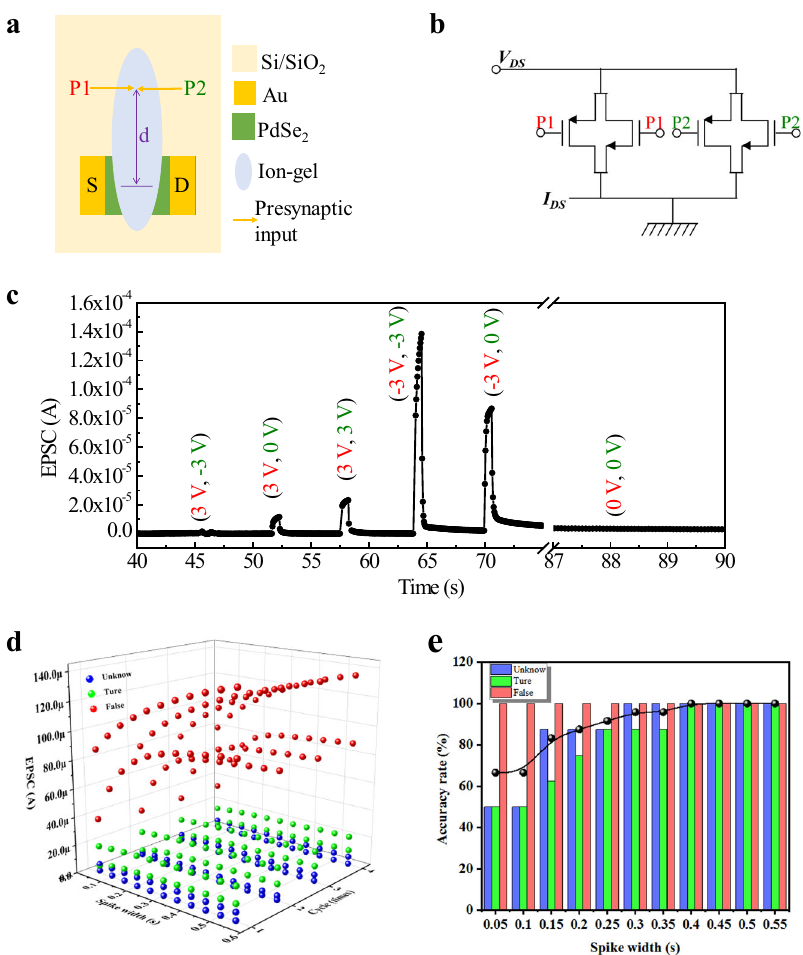
Fig. 6 Input logic signals backtrack. a Schematic image of AS with two input terminals that have identical distances from the center of the channel. b The normal logic circuits that can integrate memory and computation. c Different magnitudes of postsynaptic current stimulated by six different combinations of input logic signals. d Data set were collected to train SVM. e The result of analogous simulation, which shows with the increasing of the spike duration the accuracy can achieve (Supplementary Fig. 5c) and spike-voltage dependent plasticity